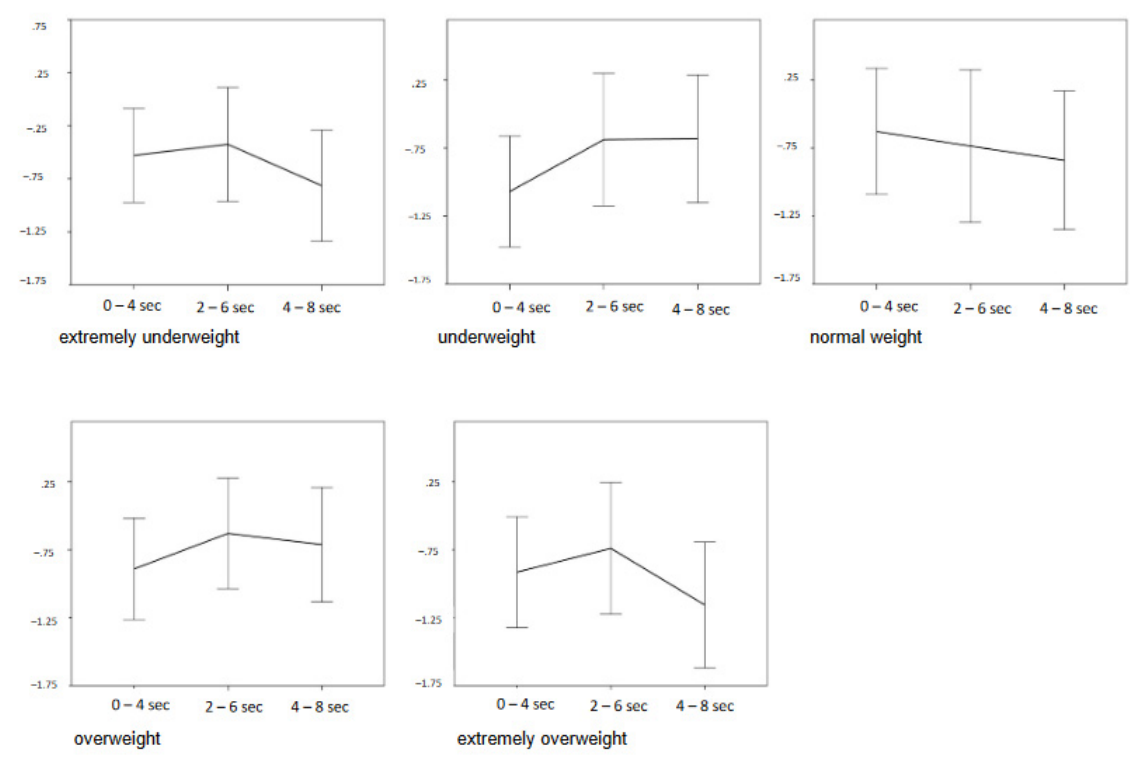
Figure 3. Time course of HR of all participant groups across time segments ( x axis) in difference scores ( y axis: mean HR in the respective time segment in relation to baseline HR, beats per minute), mean +/ − 2 standard errors.